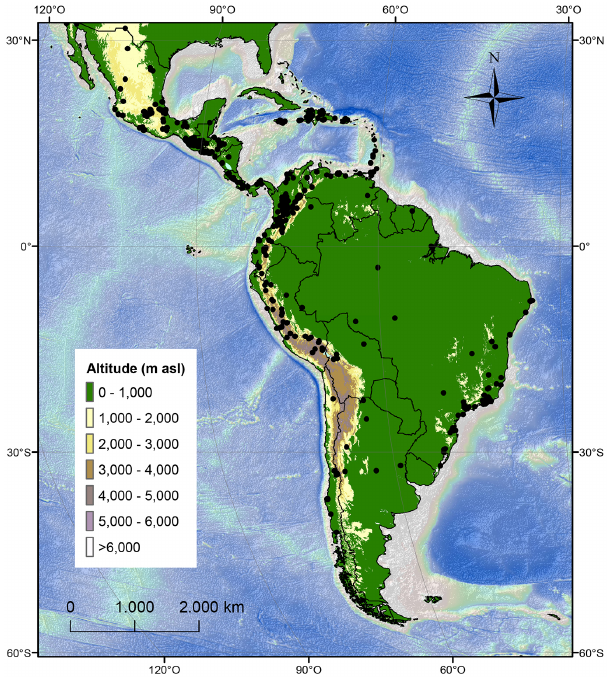
Figure 2. Location of fatal landslides in Latin America and the Caribbean (black dots) in the period 2004–2013 according to the FIGURE 1 Figure 1. Number of (a) fatal landslides and (b) fatalities caused by landslides in the period 2004–2013 in Latin America and the Caribbean, based on monthly records. The lines show the cumu- lative records, showing a smooth curve for the landslides and a stepped curve for the fatalities due to catastrophic events with large number of deaths on single landslides or multiple events in a matter of a few days.